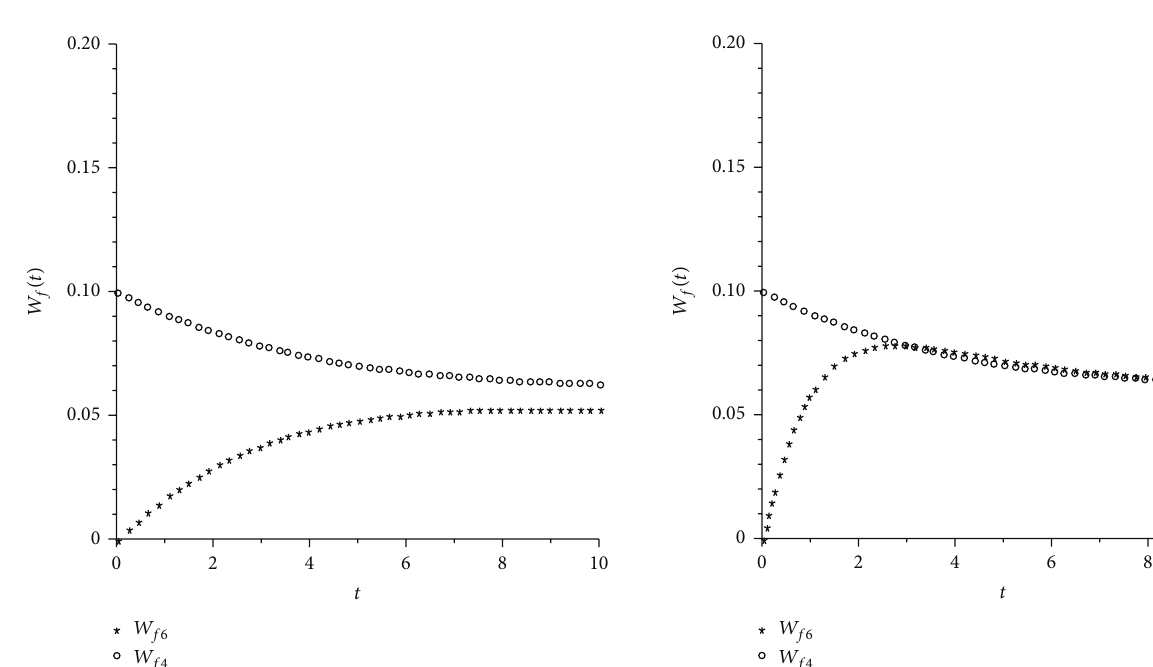
1 ≫ 𝜆 , the instantaneous failure frequency of the system with warning device is larger than that of the system without warning